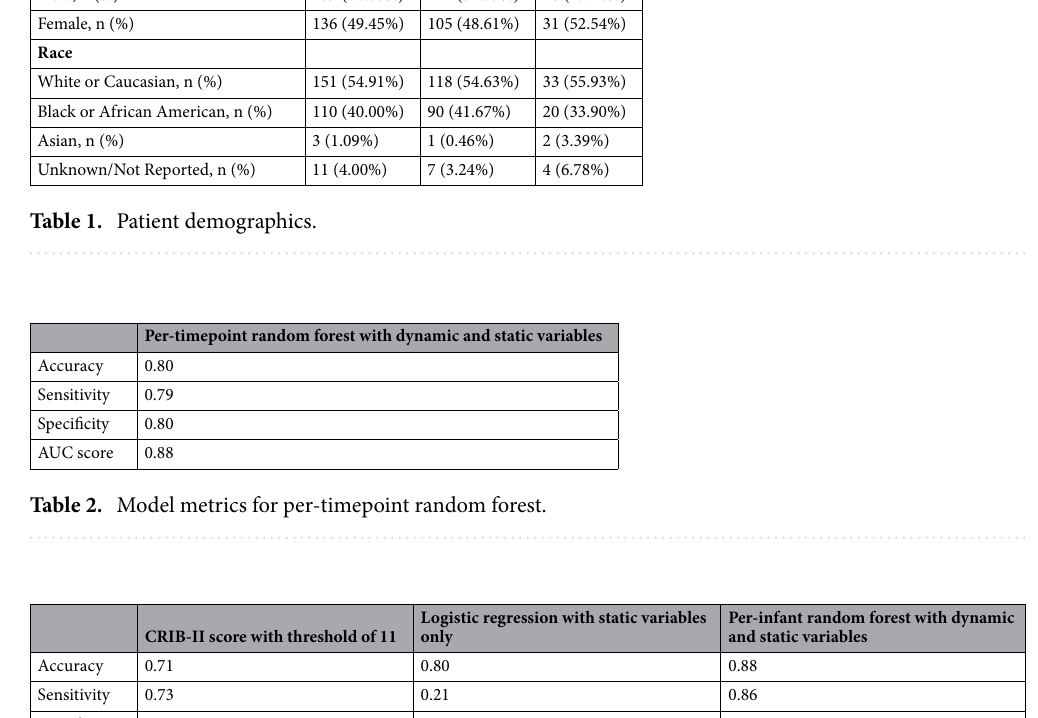
CRIB-II score with threshold of 11